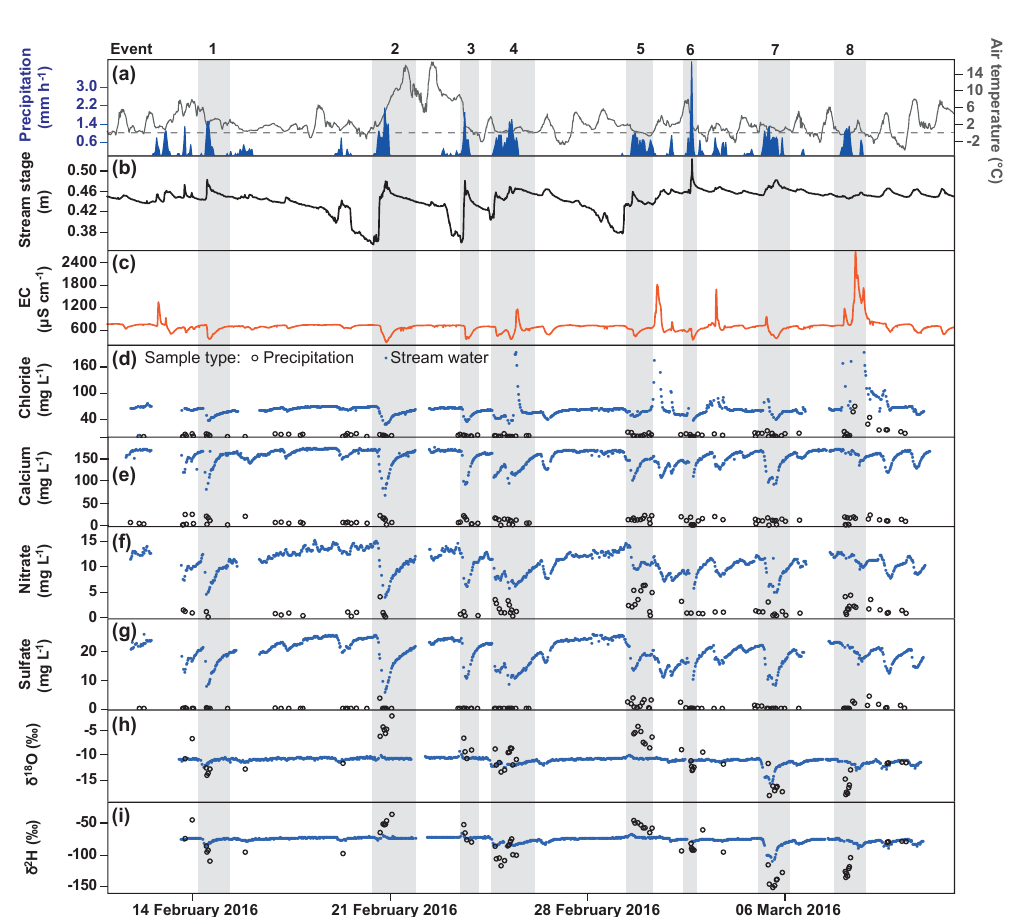
Figure 5. Time series of (a) precipitation and air temperature as well as (b) stream stage at the field site during the 4-week study period. Panel (c) shows stream water EC, whereas panels (d–g) show the chloride, calcium, nitrate, and sulfate concentrations, respectively. Pan- els (h) and (i) show the isotopic compositions of precipitation and stream water samples. The stream water samples are shown by the blue dots, and the precipitation samples are shown by the open circles. The vertical grey bars indicate the periods of the eight precipitation events used for hydrograph